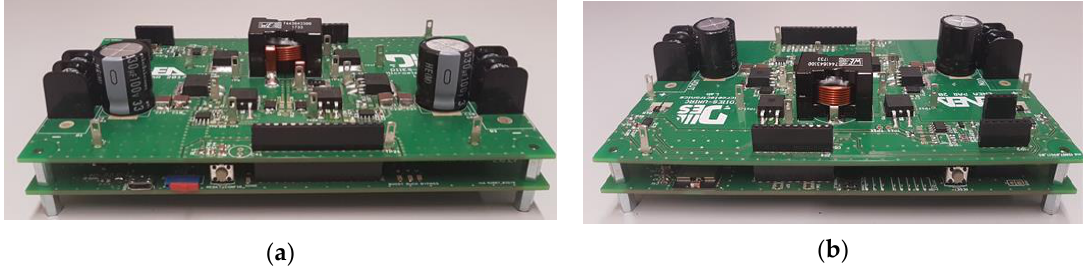
Figure 7. Maximum Power Point Tracking ( MPPT) front ( a ) and back ( b ) view.